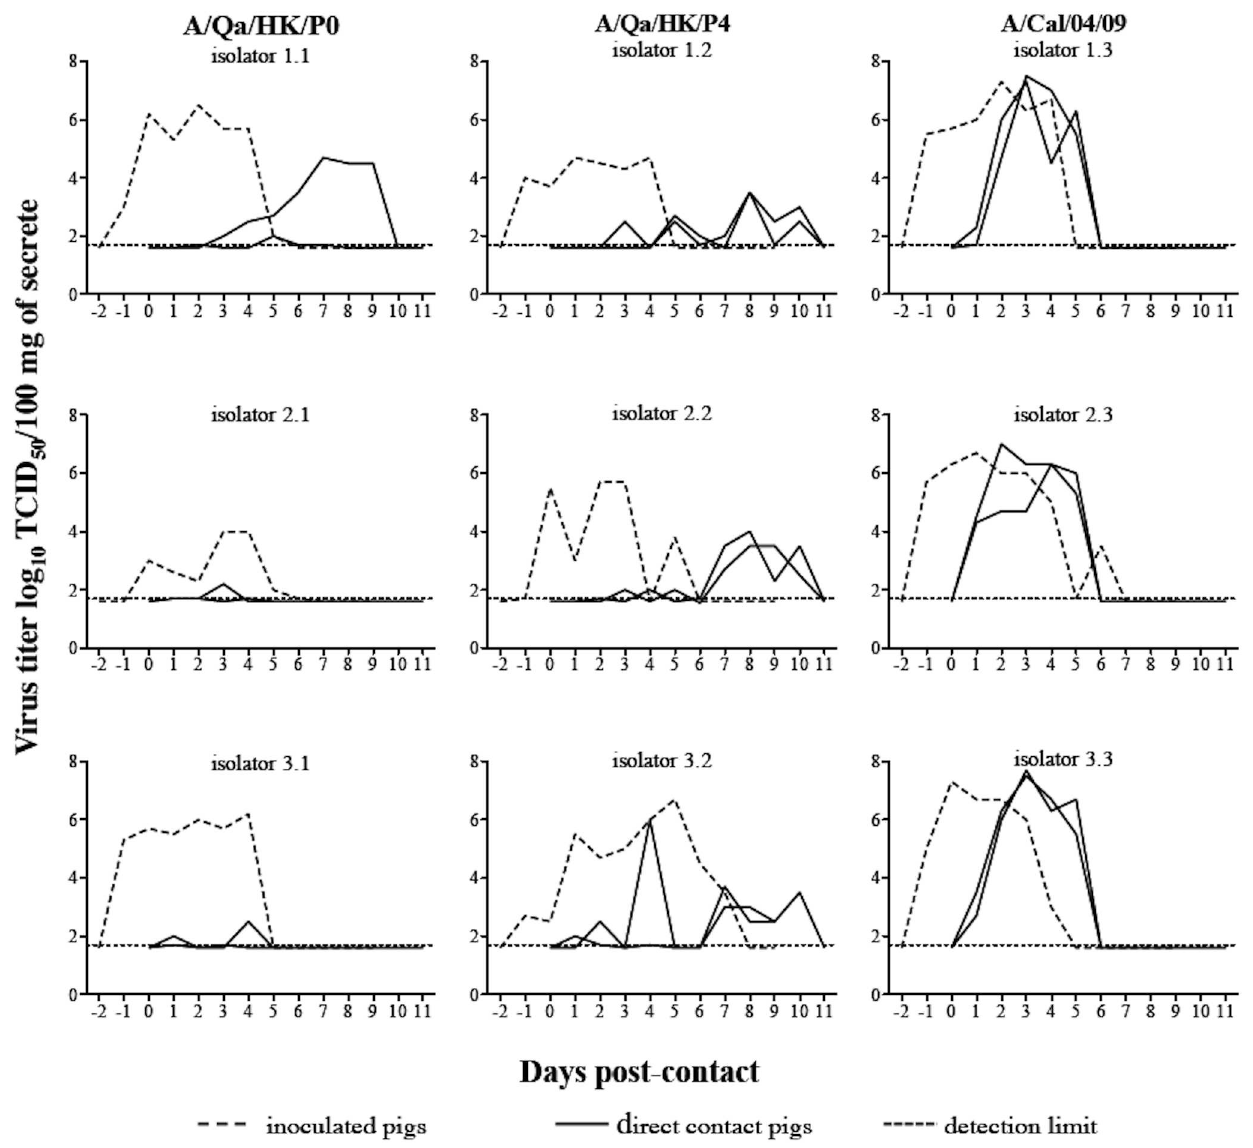
Fig 2. Nasal virus excretion and direct contact transmission of A/Qa/HK/P0, A/Qa/HK/P4 and A/Cal/04/09 influenza viruses in pigs. Three pigs were intranassally inoculated with 6.5 log 10 TCID 50 of the indicatedvirus per pig and individuallyhousedin different isolators. Forty- eight hours later, two direct contact animalswere co-housed with the inoculatedpigs. Each graphicis identifiedwith a two digits number: the first one corresponds to the isolator number and the second to the virus tested. Therefore, each column representsa different virus and each row representsa different isolator. The detectionlimit (dotted line) of the test was 1.7 log 10 TCID 50 /100 mg of secrete.